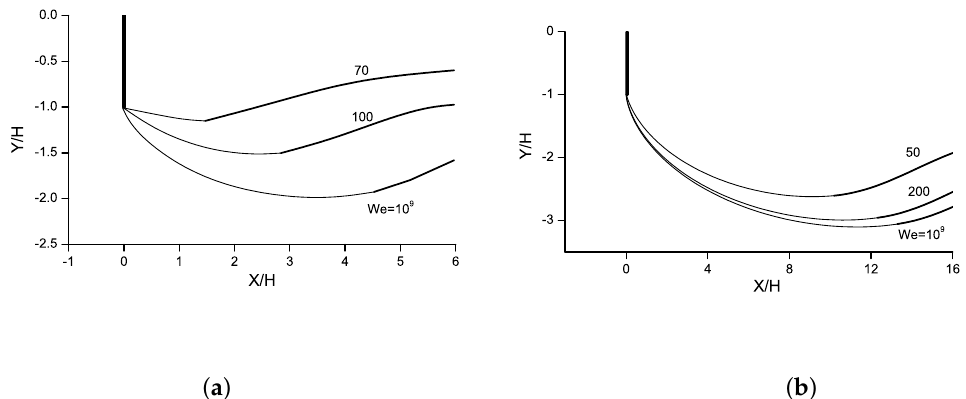
Figure 2. Cavity contours for various Weber numbers for edge radius r = 0.05 and cavitation number: ( a ) σ = 1.0 and ( b ) σ = 0.5.